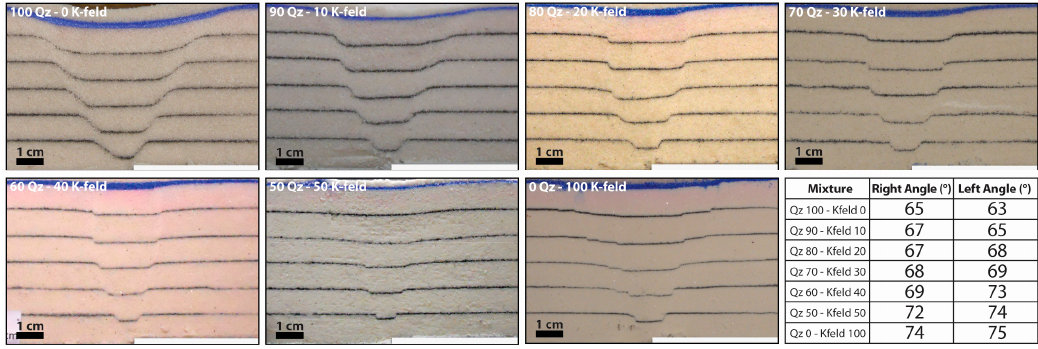
Figure 6. Cross sections of the extensional models used to determine the internal friction angle for the different sand mixtures. The white bar on the lower right angle of each panel indicates the moving metal basal sheet acting as a velocity discontinuity. The table in the right bottom panel summarizes the dip angles of faults on the right and left side of the VD (see text for details).